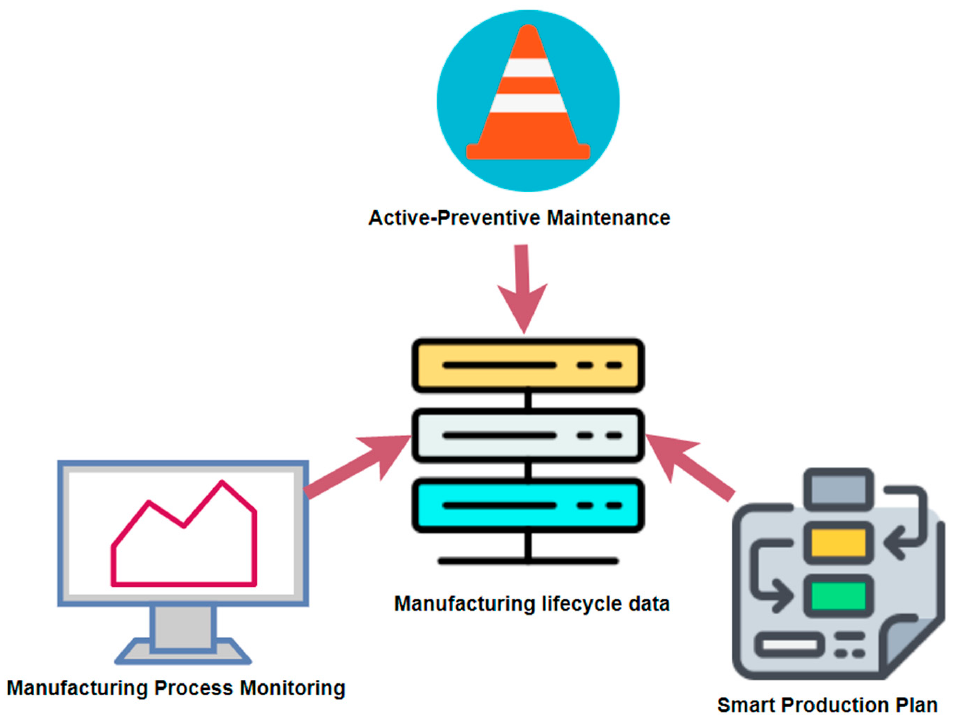
Figure 3. Manufacturing lifecycle data. (Graphics source: https://online.visual-paradigm.com/, accessed date: 14 June 2021).